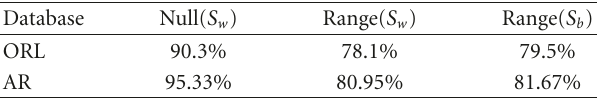
Table 2: Recognition accuracy of EDFE in di ff erent subspaces.